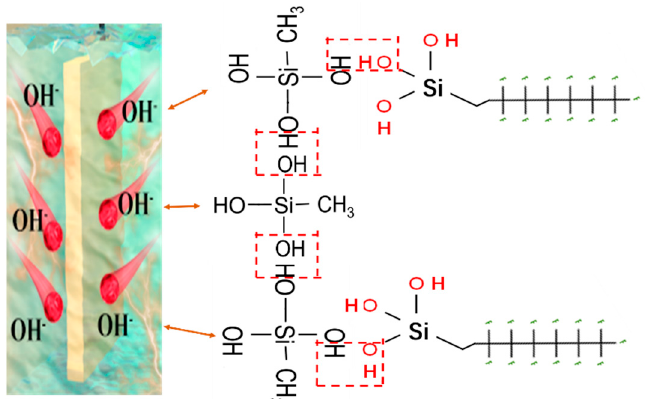
Figure 7. Illustration of the chemical bonds between the E-MTES layer and substrate and between PFOTS and E-MTES layers.